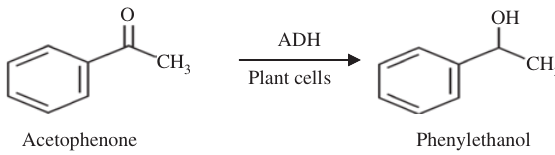
Figure 1: Asymmetric reduction of acetophenone (ACP) catalyzed by freeze-drying